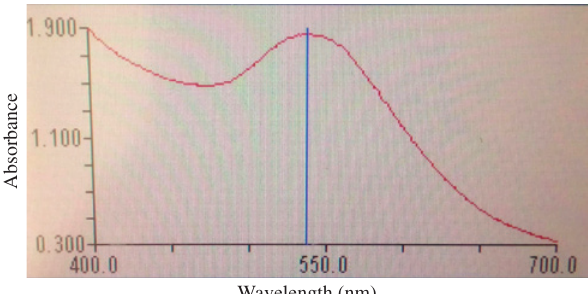
Figure 6: UV-Vis spectra of the mixture solution containing HAuCl and mushroom extract, after synthesis with exposure to microwave